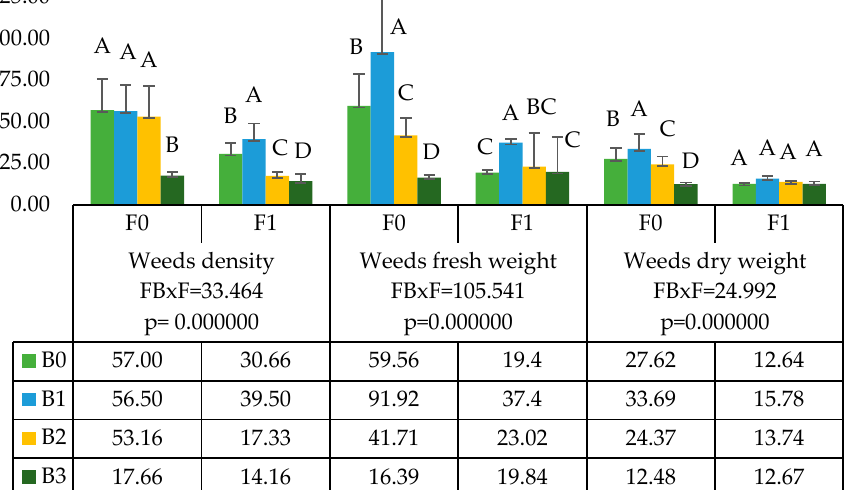
Table 6. Biochar and fertilization effects on weed density (m − 2